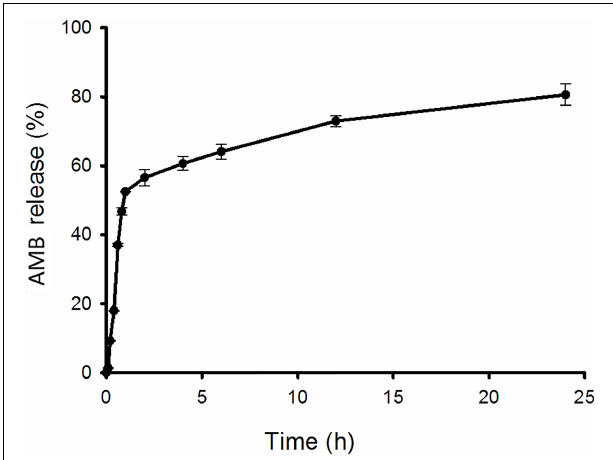
FIGURE 2 | In vitro release kinetics of AMB from the nanoparticle (NP). CSNPs-AMB-Gls was placed in polybutylene succinate (PBS) with stirring. The amount of AMB in the solution was measured at 405 nm by UV spectrometry at any given time